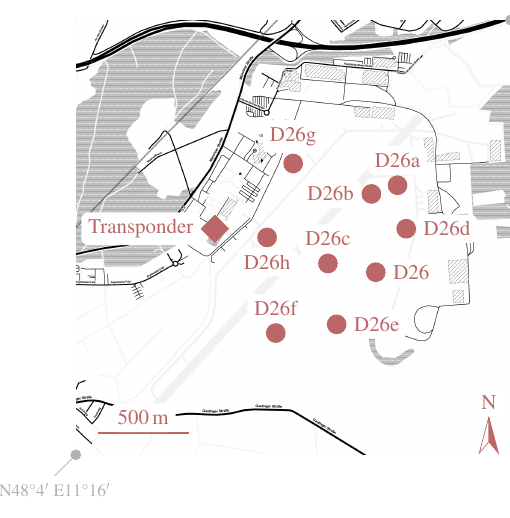
Figure 2. Locations of the transponder on the DLR premises and of the 1 . 5m corners on the adjacent airport in Oberpfaffenhofen, Germany. (Map tiles in this and Figure 3 reproduced with permission from Stamen Design, based on data from OpenStreetMap.)